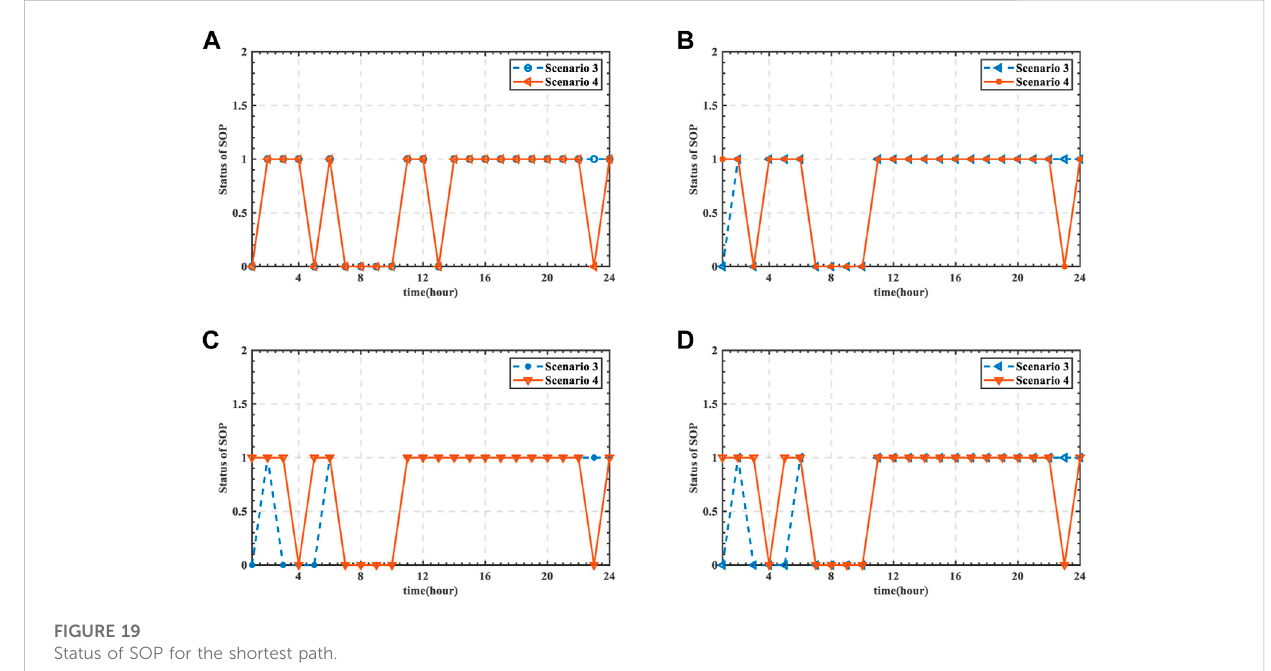
FIGURE 19 Status of SOP for the shortest path.